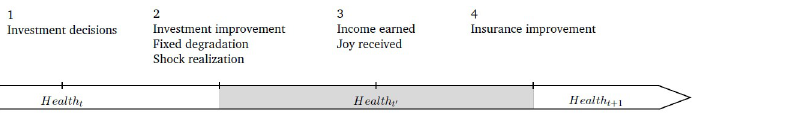
Fig 1. Sequence of events within a